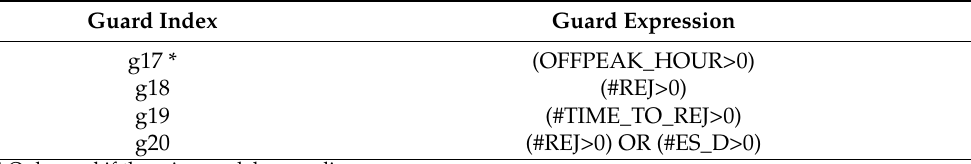
Table 5. New guard expressions for the model C